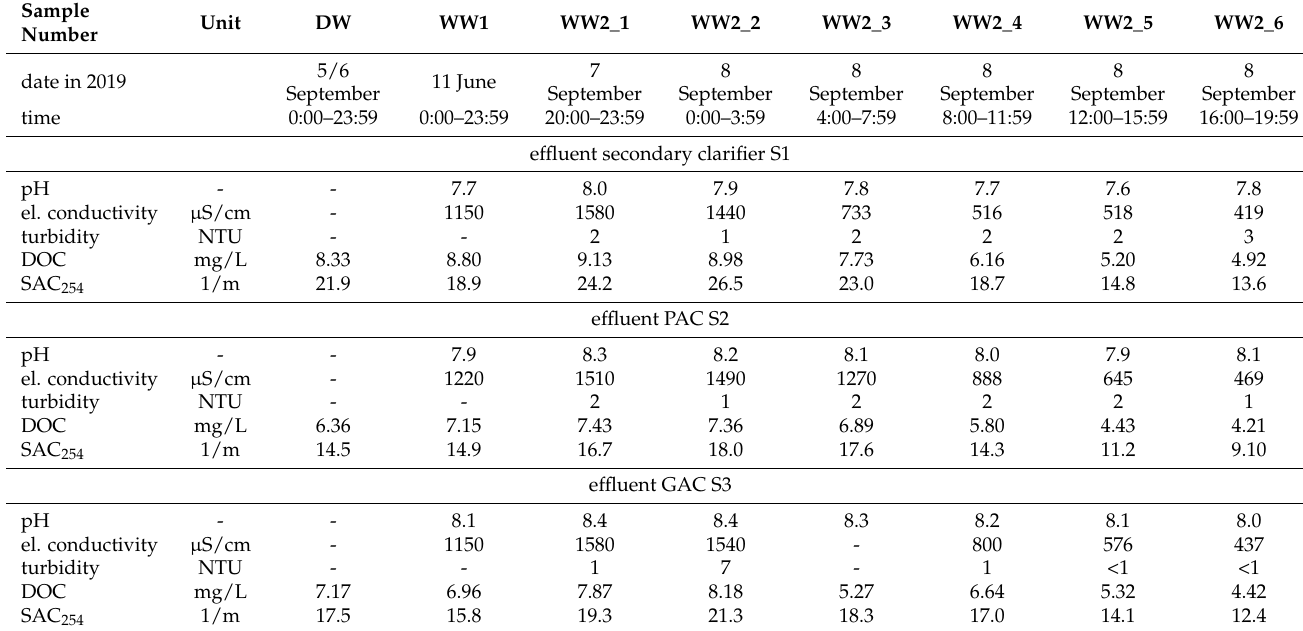
Table 1. Standard wastewater parameters of the samples during dry weather (DW) and wet weather WW1 and